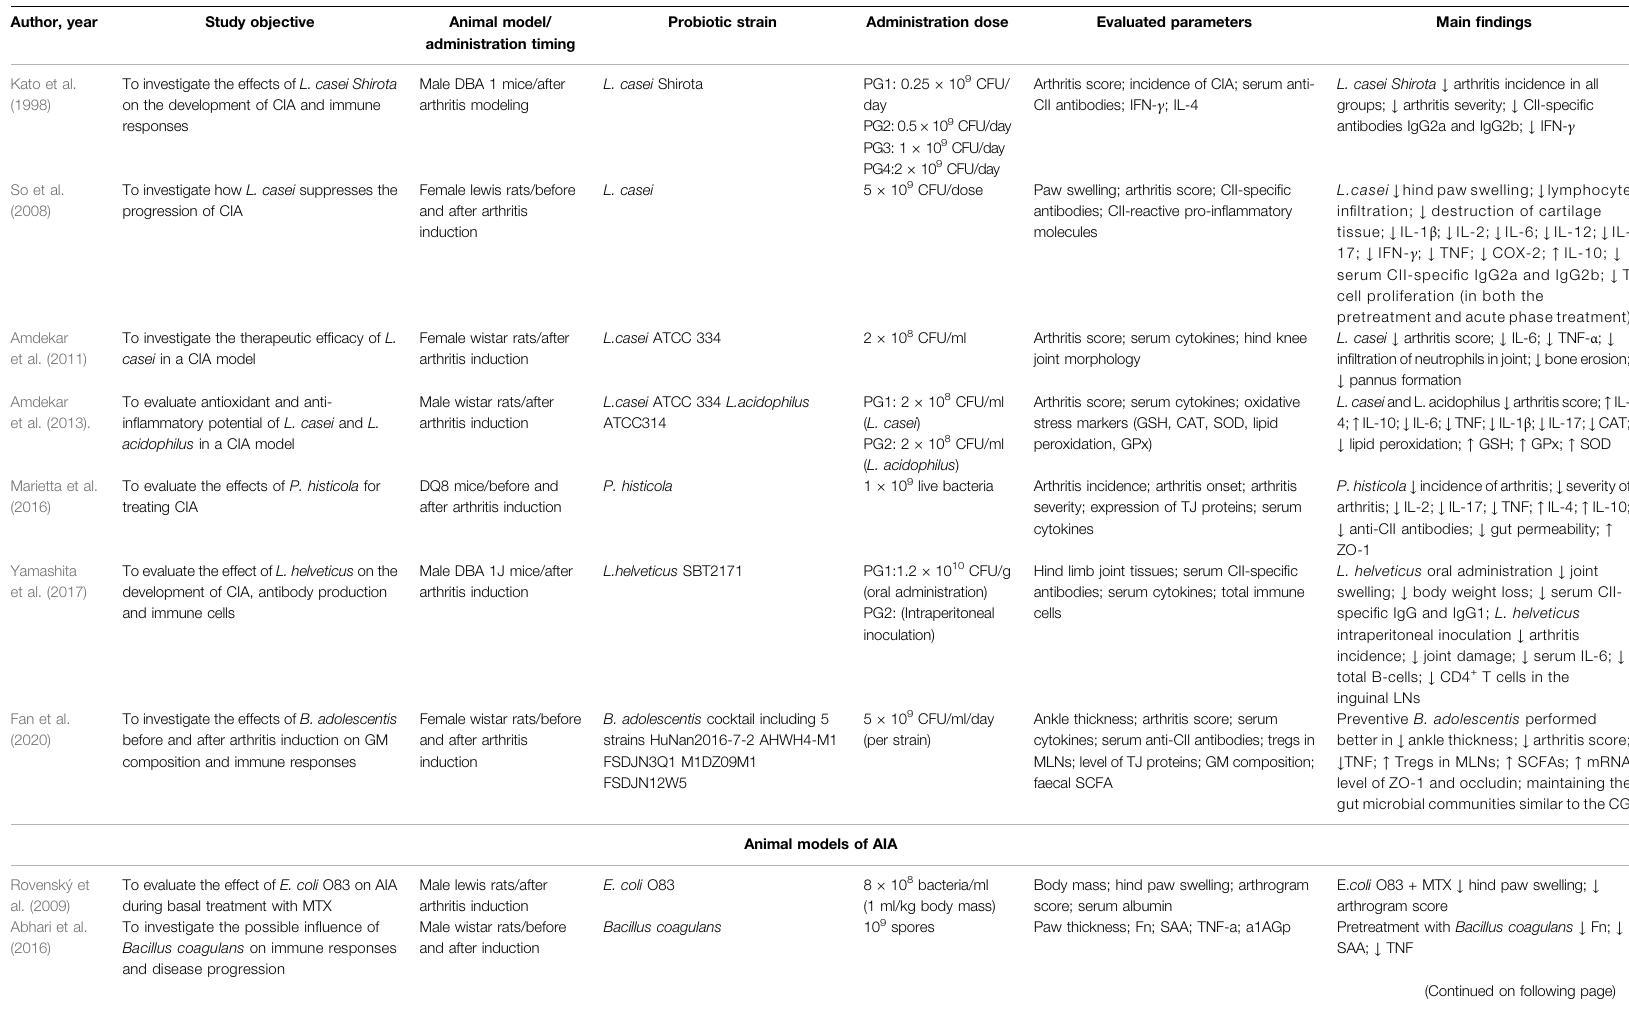
TABLE 1 | Probiotic effects on animal models of